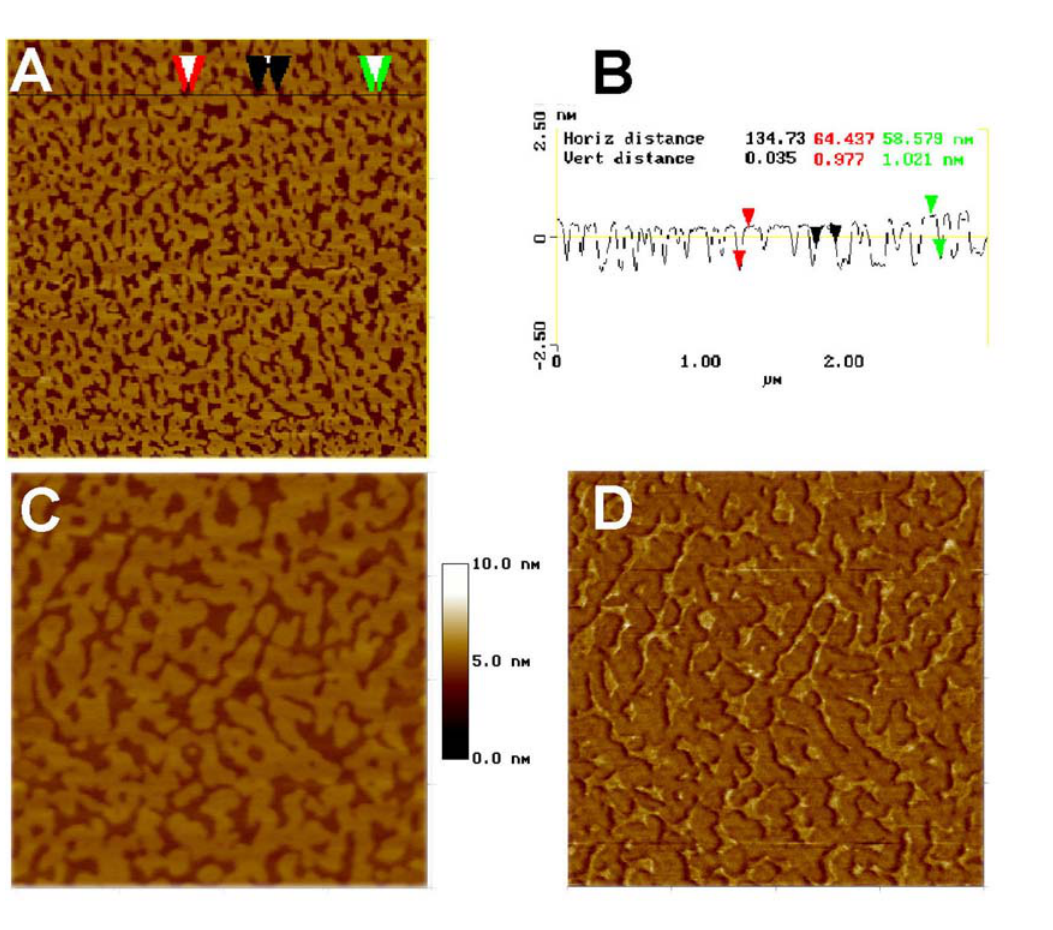
FIGURE 3 . AFM imaging of bovine brain SM transferred at 30 mN/m. (A) Height image of SM, scan size 3 × 3 µm; (B) virtual sectioning corresponding to the horizontal black line drawn in A. Ordered (lighter) domains protrude by ~1 nm (red and green arrows) from the fluid matrix. Width of the ordered domain marked by dark arrows is ~135 nm; (C) height image at a higher magnification (scan size 1 × 1 µm). The color scale on the right gives the relative height of structures; (D) friction image obtained